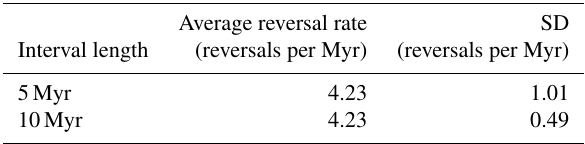
Table 1. Time-averaged VADM and VADM standard deviation of PADM2M and Sint-2000.